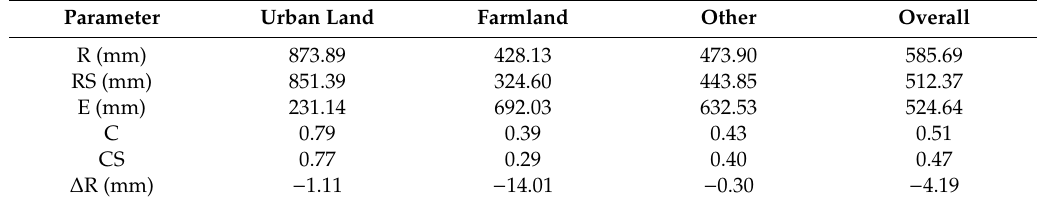
Table 5. Annual average simulation results for rainfall-based runo ff from the period